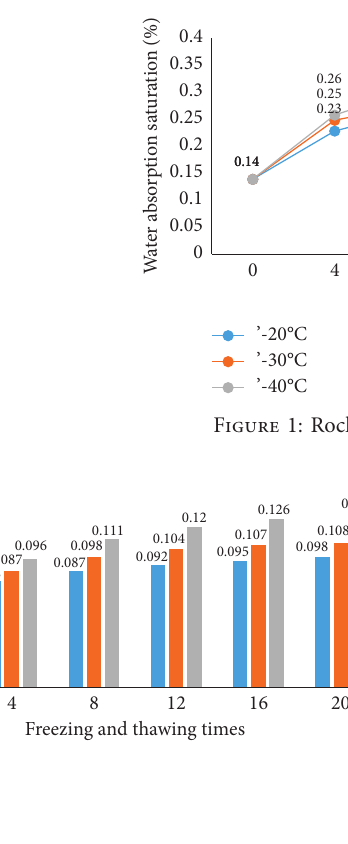
Figure 2: Mass loss rate of rock